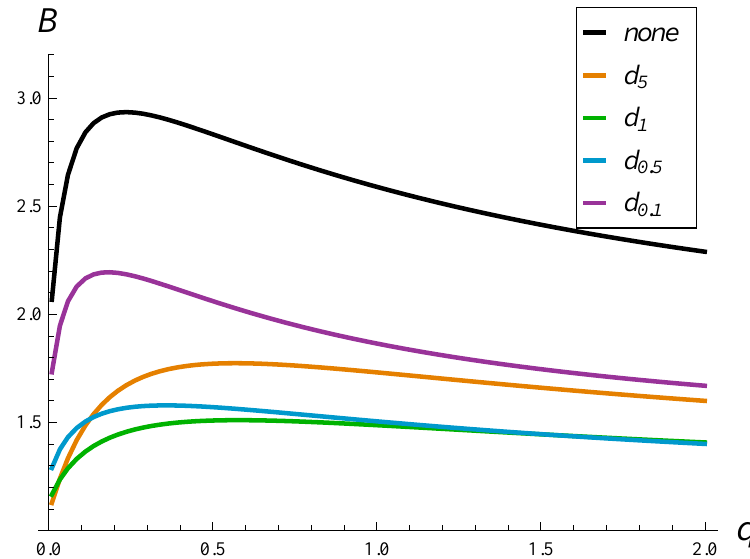
Figure 2. Burst ratio vs. the autocorrelation strength for a few functions d ( n ) and no AQM. Link load ρ = 0.8.